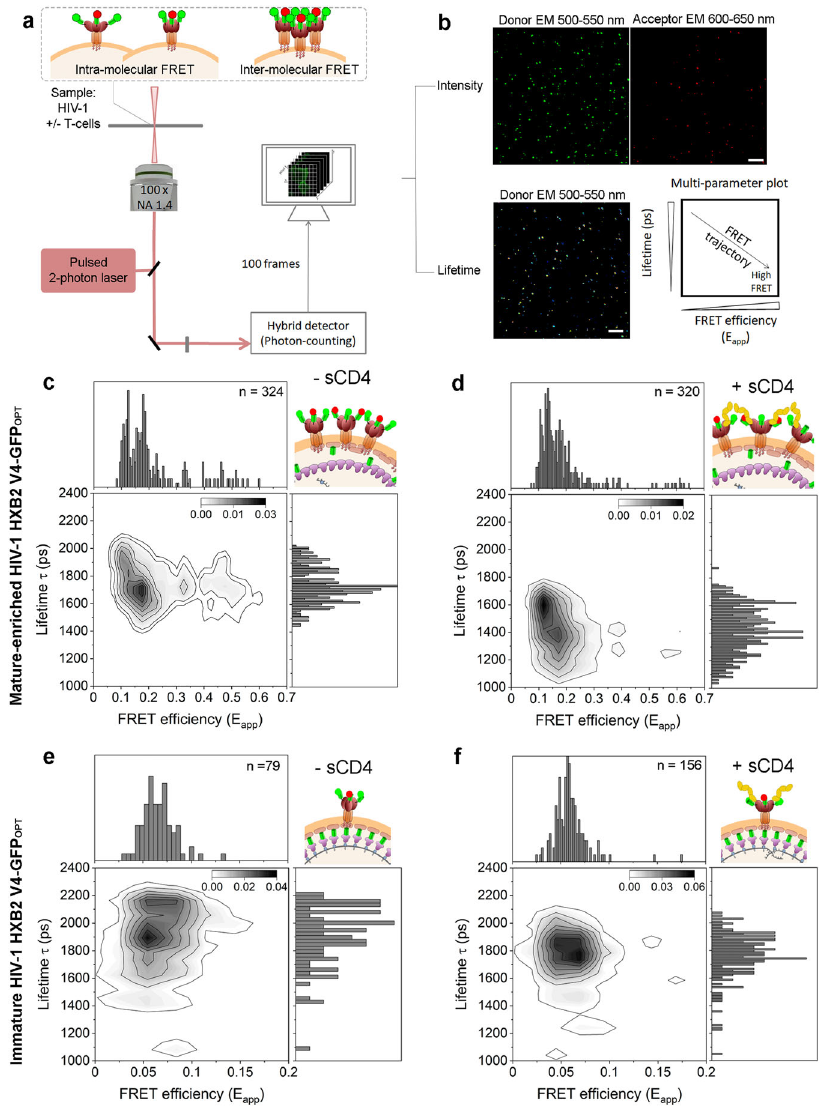
Fig. 2 Two Photon FRET-FLIM detects HIV-1 Env conformations. a Schematic representation of the FRET-FLIM system setup. Intramolecular FRET between Env trimer labels is resolved in sparse Env molecules whereas inter-molecular FRET is observed upon Env-Env association. Samples of HIV-1 virions in the presence or absence of T cells were imaged using a Leica DIVE two-photon system equipped with a pulsed two-photon laser tunned at 950 nm, a 100× magni fi cation objective and photon-counting technology. The simultaneous intensity and lifetime measurements were obtained in 100 frames acquisitions (see material and methods for further details). b Micrographs showing images corresponding to intensity-based measurements obtained in two independent channels: donor emission (500-550nm) and acceptor emission (600 – 650 nm) or to lifetime measurements of the donor. Scale bar 10 µ m. Data from donor lifetime (ps) and calculated apparent FRET ef fi ciency from intensity-based measurements is represented in kernel multi- parameter plots. In presence of both, donor and acceptor, FRET values experience a shift towards positive values concomitant with a drop in lifetime. ( c – f ) Two-dimensional (2D) kernel probability graphs showing FRET (FRET ef fi ciency, E app ) vs FLIM (Lifetime, in ps) data. High-density regions are depicted in darker grey color. c , d Plots corresponding to HIV-1 mature HXB2 V4-GFP OPT labelled with NbA488 and NbA594 nanobodies incubated without ( c ) or with ( d ) sCD4. e , f Plots corresponding to HIV-1 immature HXB2 V4-GFP OPT labelled with NbA488 and NbA594 nanobodies incubated without ( e ) or with ( f ) 10 µ g/mL concentration of soluble CD4 (sCD4 D1-D4